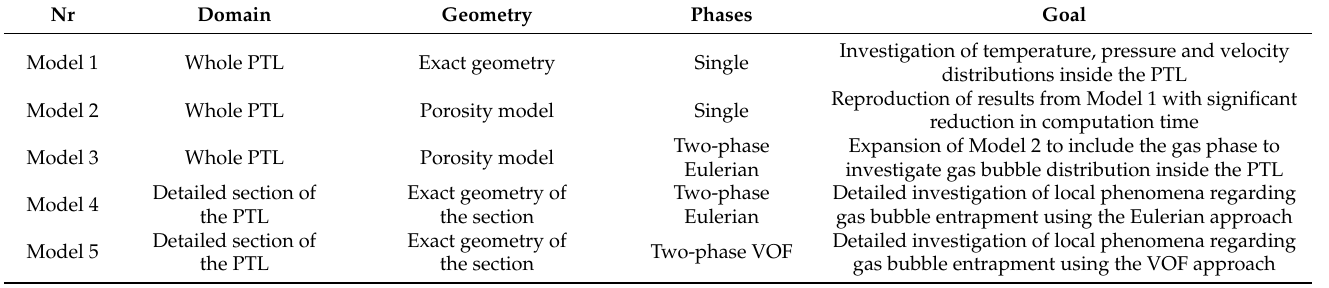
Table 3. Overview of the simulation models presented in this work and their goals.